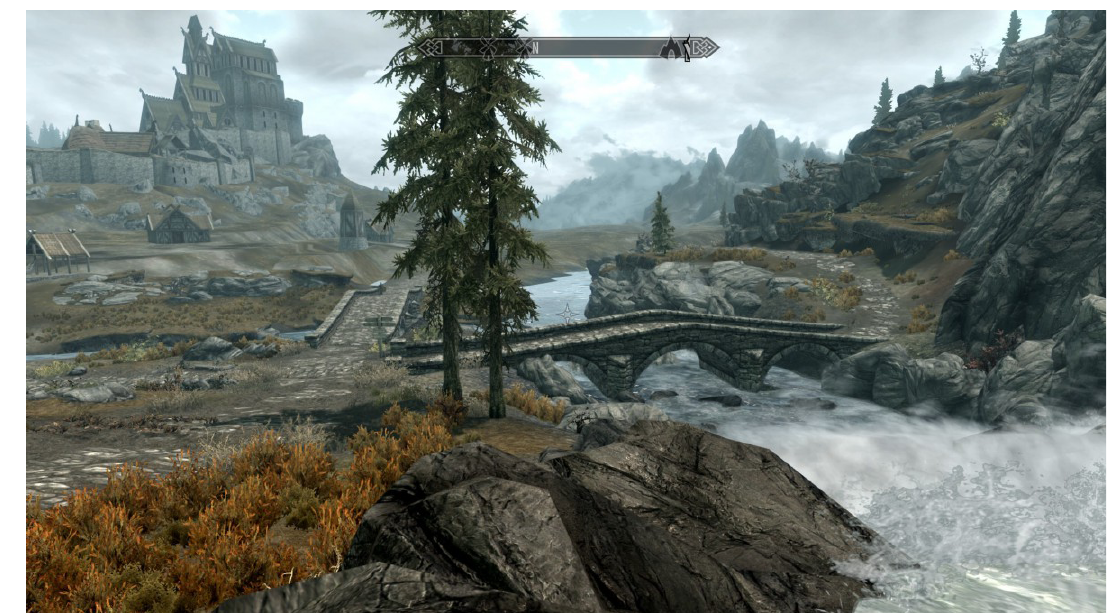
Figure 1. In-game screenshot of The Elder Scrolls V: Skyrim. Source: Livingston (2011).